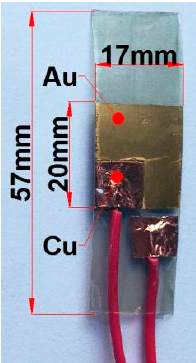
Figure 3. PVDF-TrFE/nano-ZnO piezoelectric sensor with 7.5% nano-ZnO contents has been prepared.